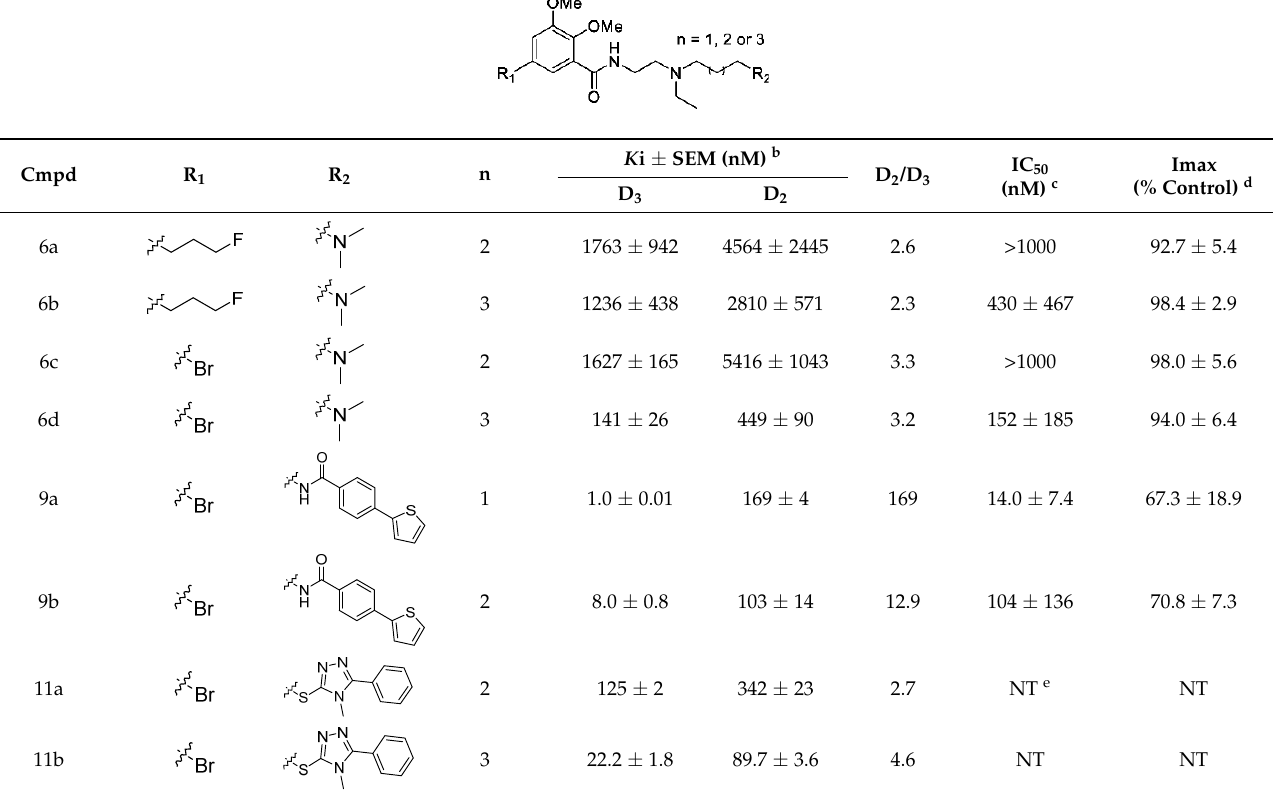
Table 1. Binding affinities and potency of R 1 and R 2 modified analogs with different length of the alkyl linker a .